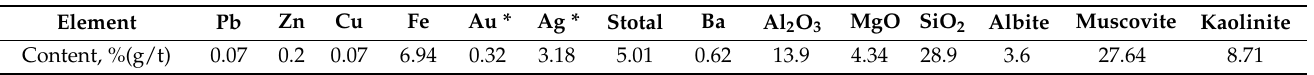
Table 2. Chemical composition of the representative sample of the old enrichment tailings from the Belousovskaya Enrichment Plant.